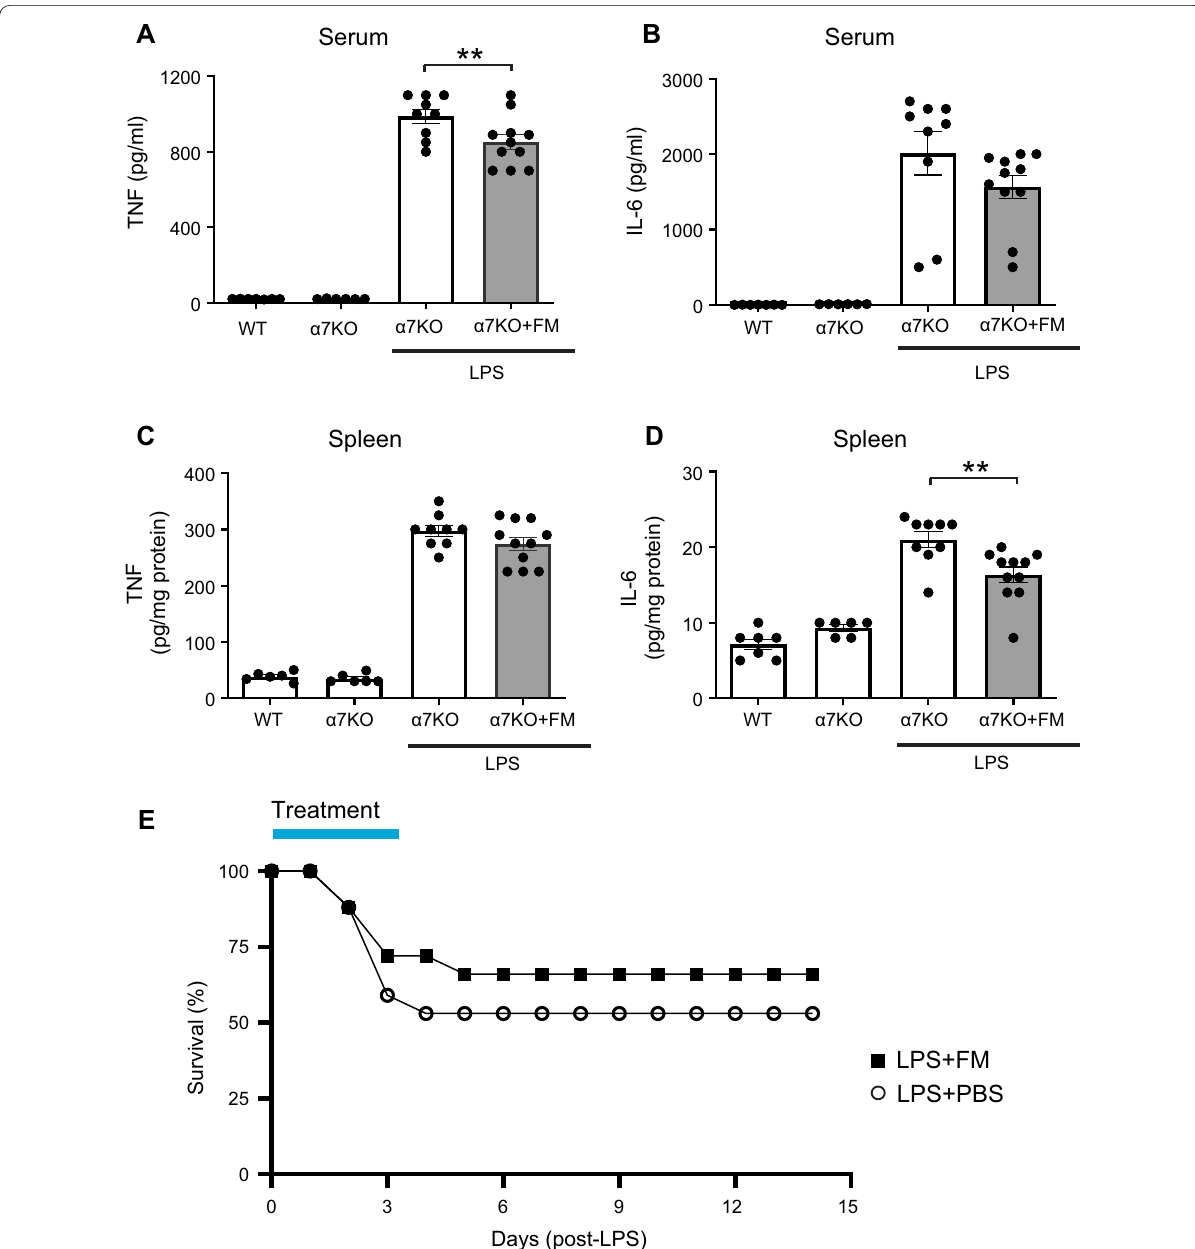
Fig. 6 Suppressive effects of famotidine on LPS-induced TNF and IL-6 release were greatly attenuated and mortality increased in α7 nicotinic acetylcholine receptor knockout mice. A – D Male C57BL/6 or α7nAChR knockout mice (α7KO; 8–12 weeks of age) received famotidine or PBS (0.4 mg/kg, in 5 µl volume) administered ICV at 30 min prior to LPS injection (IP, 7 mg/kg). Mice were euthanized 2.5 h post-LPS injection, serum and spleen TNF ( B , C ) and IL-6 ( D , E ) were measured. N 7 for wild type and 6 for α7nAChR KO controls, 9–11 per group for others. E Male = α7nAChR knockout mice, 8–12 weeks old, were injected with LPS (6 mg/kg, IP). Famotidine (FM) or PBS (4 mg/kg, in 100 µl volume) were injected intraperitoneally twice a day for 3 days, survival was monitored for 2 weeks. N 17 for PBS control and 18 for FM mice per =